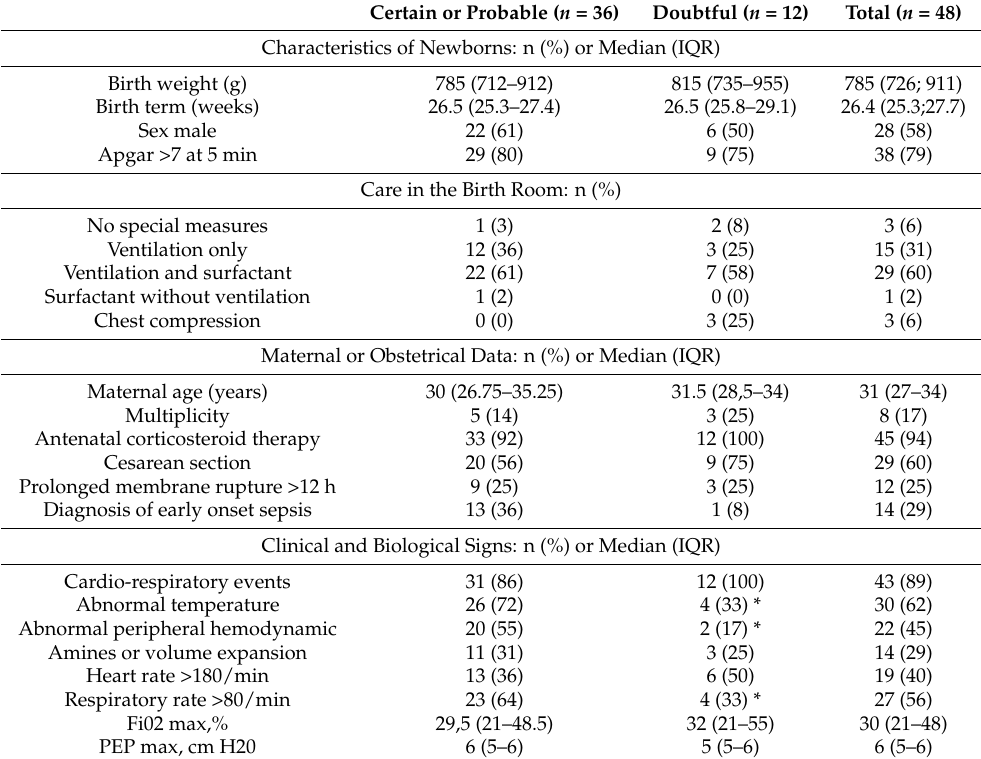
Table 1. Clinical